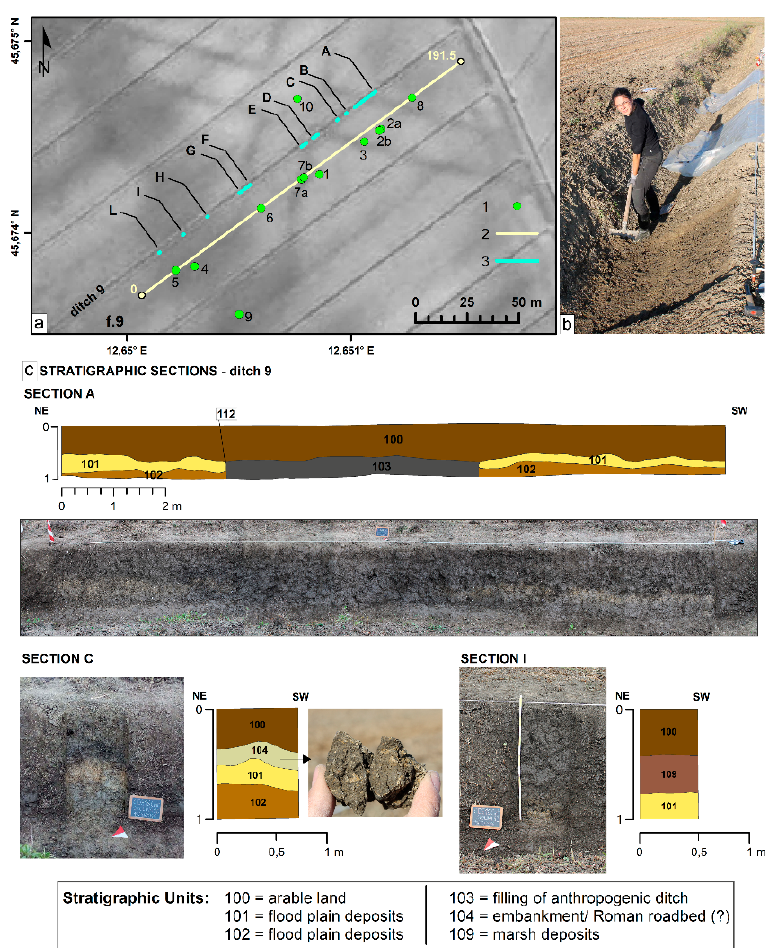
Figure 9. Cleaning of the exposed section. ( a ) Working area: (1) cores; (2) ERT line; (3) exposed sections. ( b ) Image documenting the field activity. ( c ) Stratigraphic sections detected in correspondence of some soil marks: the numbers correspond to the Stratigraphic Units (US) identified; the image shows the included angular US104 (hypothetical road/street base).